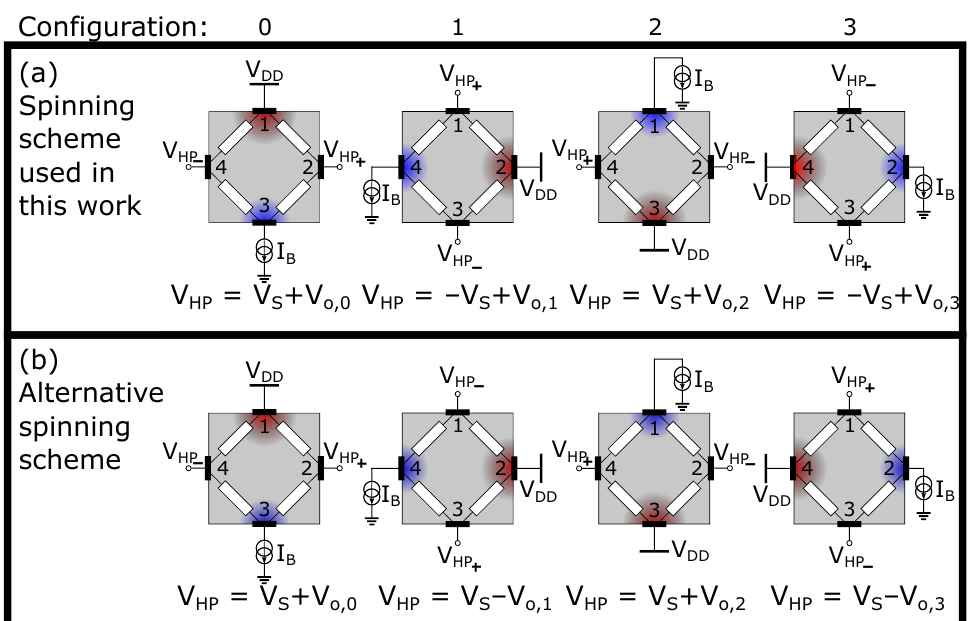
Figure 1. Different readout configurations or “phases” of a Hall plate, assuming current-mode biasing and voltage-mode sensing. Four-phase spinning consists of repeatedly cycling through the configurations on a single row from left to right. The upper scheme results in up-modulation of the magnetic signal V S , while the lower scheme up-modulates the